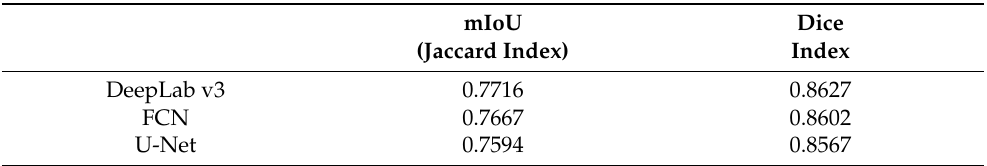
Table 3. The 3-class semantic segmentation performance measured by mIoU and Dice index based on the results from DeepLab v3, FCN, and U-Net.